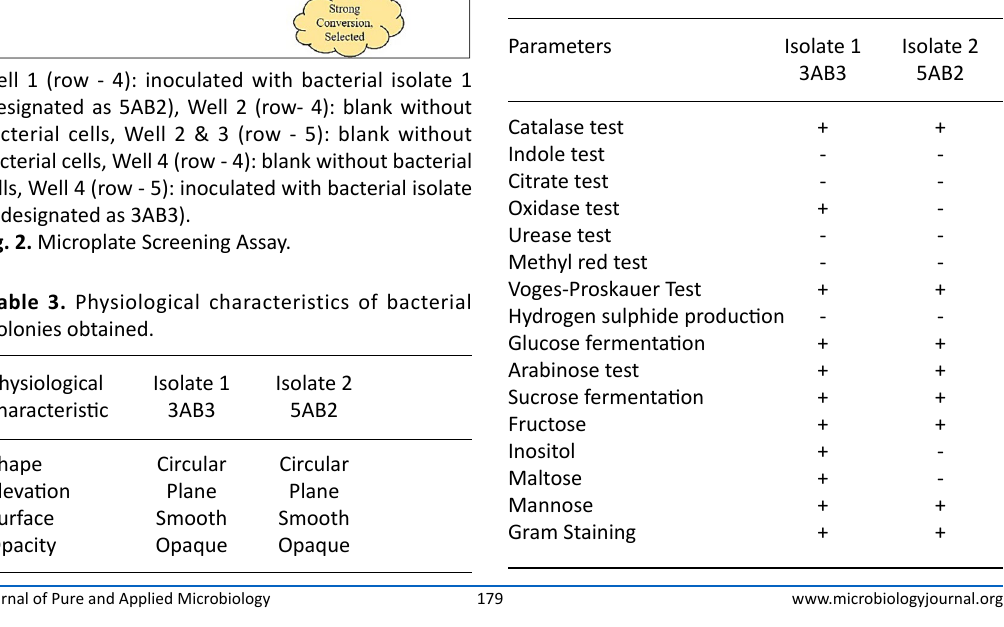
Table 4. Biochemical Properties of the Bacterial